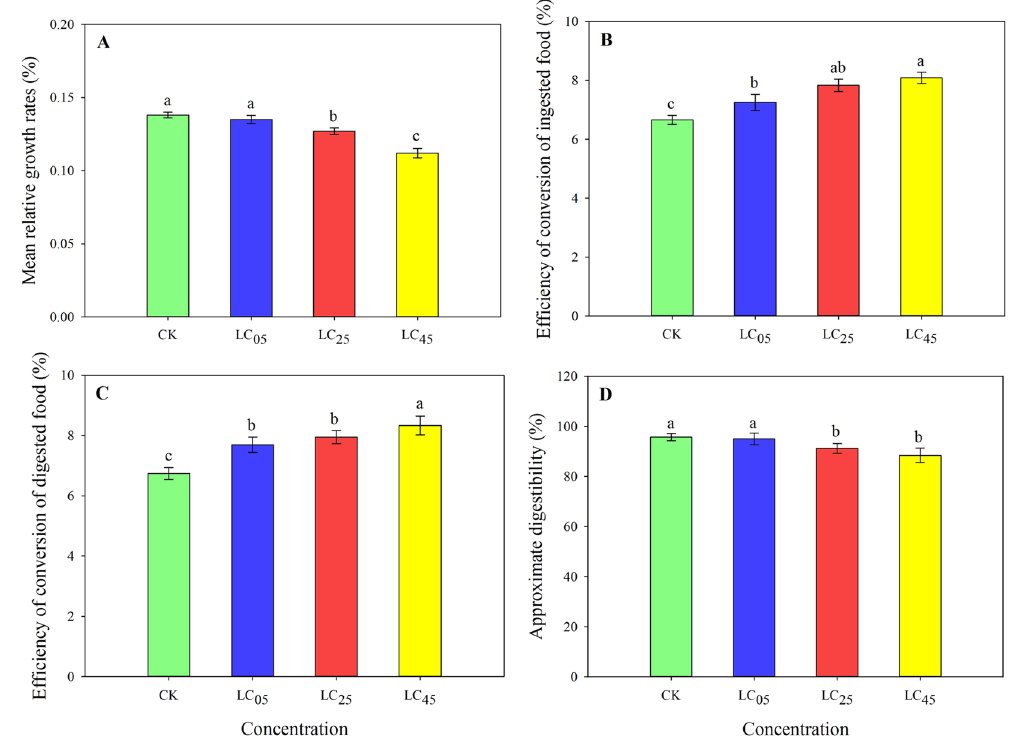
Figure 5. Nutritional indices ( A ) mean relative growth rates, ( B ) efficiency of conversion of ingested food, ( C ) efficiency of conversion of digested food, ( D ) approximate digestibility) of third-instar larvae of A. ipsilon (Mean ± SE) after exposure to low-lethal concentrations of chlorantraniliprole. Bar with the same lowercase letters show no significant differences (Student-Newman-Keuls test, P <